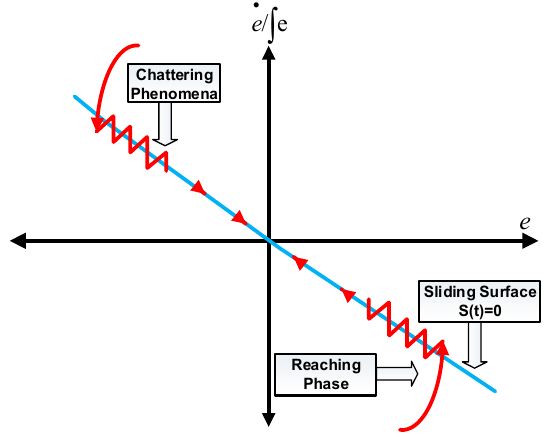
Figure 3. Graphical interpretation of the sliding mode controller [62].